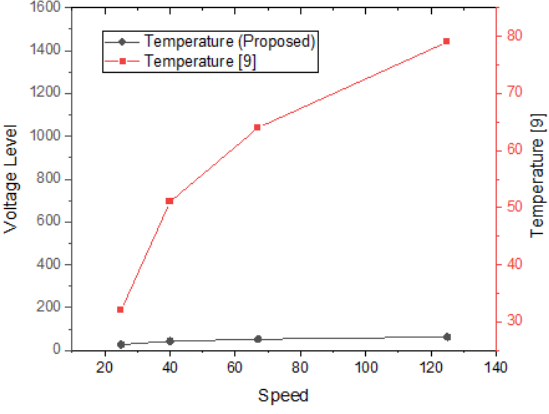
Figure 6. Reflection of temperature.